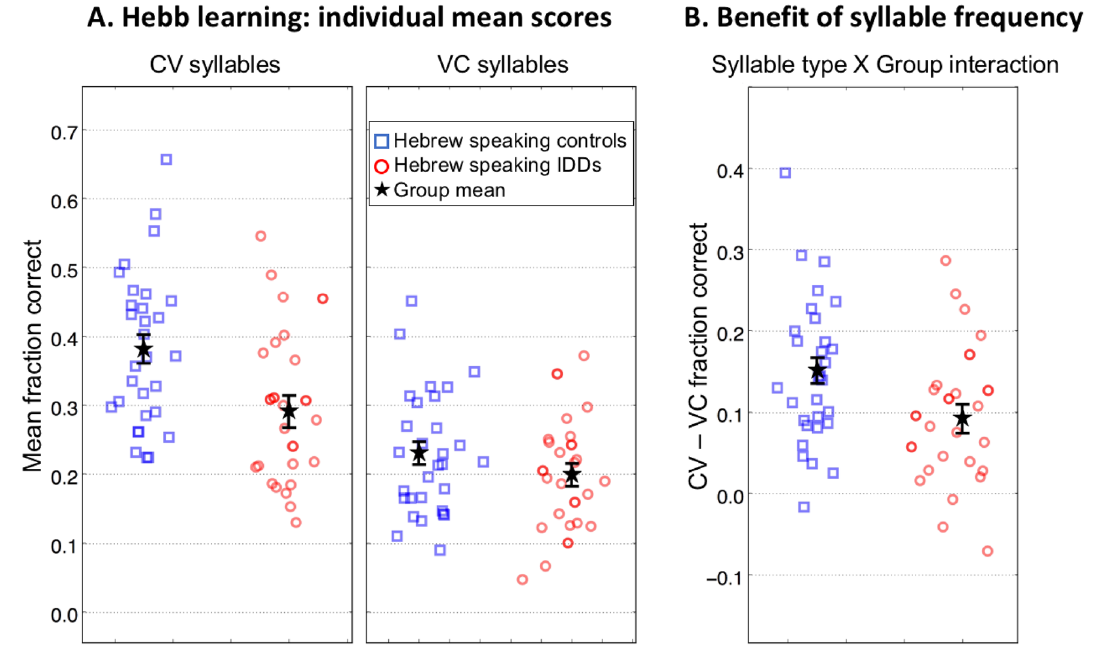
Figure 2. Hebb repetition-learning paradigm: sensitivity to order using frequent (CV) and infrequent (VC) syllables: Hebrew speakers, controls vs. IDDs. ( A ) Mean scores across all sequences in the Hebb-learning protocol of controls (blue squares) and of IDDs (red circles). Left: frequent (CV) syllables. Right: infrequent (VC) syllables. ( B ) Benefits in spans (score differences) of CV compared with VC (long-term frequency effect). Controls gained more than IDDs from the use of the frequent CV syllables. Each symbol denotes a single participant’s mean score across all 30 sequences of the Hebb-learning protocol. Error bars denote one SEM.